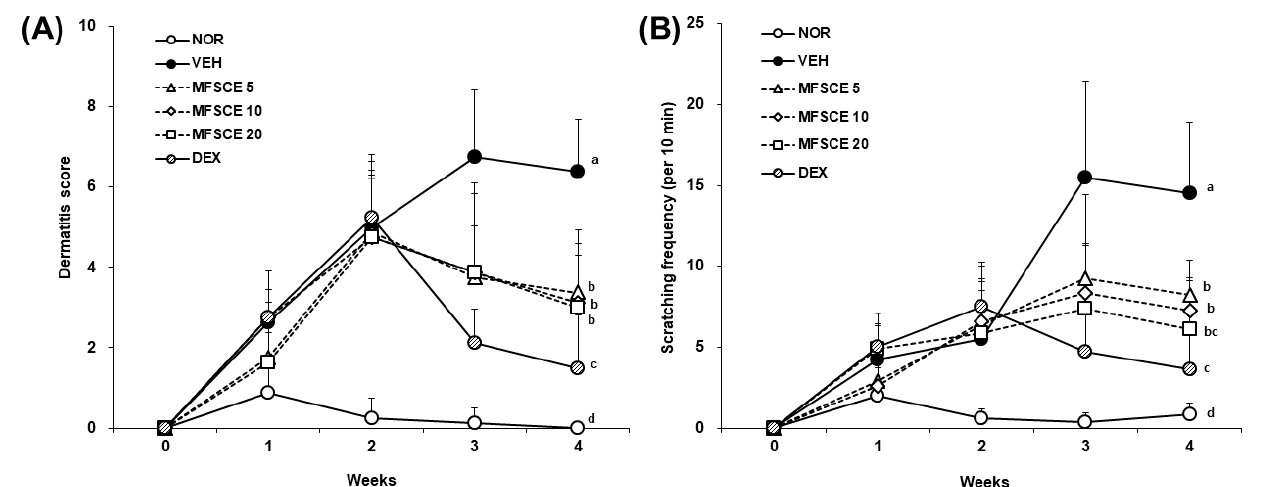
Figure 3. Effect of MFSCE on AD-like symptoms in HDM-sensitized NC/Nga mice. ( A ) Dermatitis scores. ( B ) Scratching frequency. Values are mean ± SD. a–d Means with different letters are signifi- cantly different ( p < 0.05) as determined by Duncan’s multiple range test. The mice were grouped and treated as described in Figure 2.